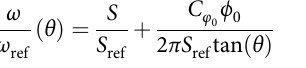
effective areas of the JIs decreases upon increasing the magnitude of the magnetic fi eld and so the period of oscillations increases. While the two JIs have been fabricated with nominally identical areas, to exclude that the observed difference in frequencies between the two JIs is due to a difference of areas, we plot in ð θ Þ measured at different angles θ . Fig. 5c, the frequency ratio ω ω ref Because each curve contains several periods T i , the frequency ratio is obtained from the average between the N periods ratio as P T i ; ref ω = ω ¼ 1 N , where T i ,ref and T i are the i th oscillation ref i ¼ 1 T i N period for the reference and for the anomalous device respectively. This method enables ignoring the fl ux focusing effect because the ratio is only taken between two periods measured at about the same magnetic fi eld. We fi nd that the experimental data follows the relation: